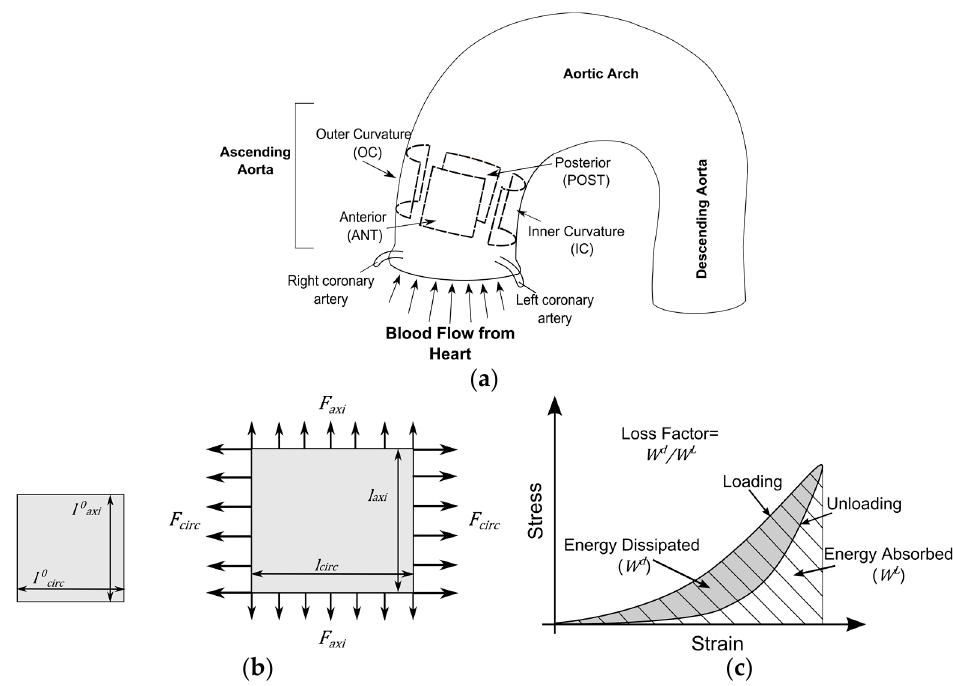
Figure 1. ( a ) Illustration of the ascending thoracic aorta (ATA) and the aortic quadrants; ( b ) A tissue sample in its initial load-free configuration ( left ), and when it is under the biaxial tensile loads ( right ); ( c ) Typical non-linear stress-strain behavior of a tissue sample subjected to a loading-unloading tensile cycle and the definition of loss